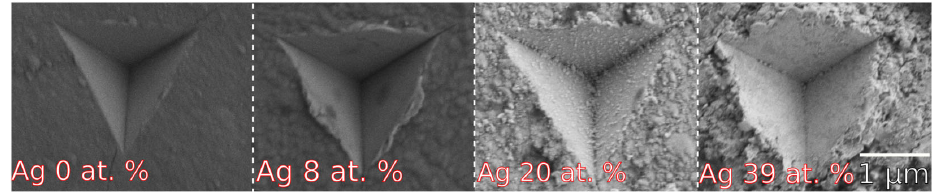
Figure 5. Top view on the cube-corner nanoindentations of the reference ZrB 2+ Δ and Zr 1 − x Ag x B 2+ Δ fi